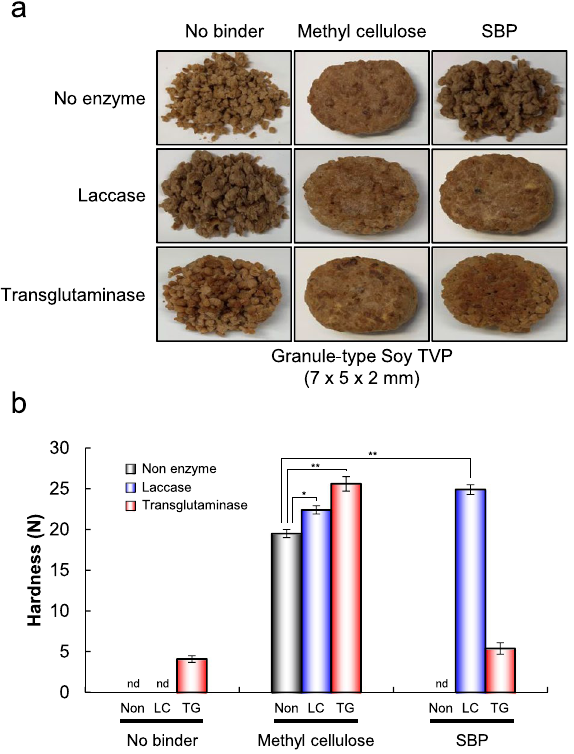
Figure 2. Appearance of grilled meat analogs treated with enzyme. ( a ) Meat analogs were treated with 20 U/g-TVP LC and 50 U/g-TVP TG, in the presence or absence of a binder (MC or SBP). ( b ) The hardness of meat analogs treated with each enzyme was measured using a rheometer. Data are presented as mean ± standard deviation of five experiments. * p < 0.05, ** p < 0.01, Student’s t -test. Non, non-treated meat analogs; LC, LC-treated meat analogs; TG, TG-treated meat analogs.